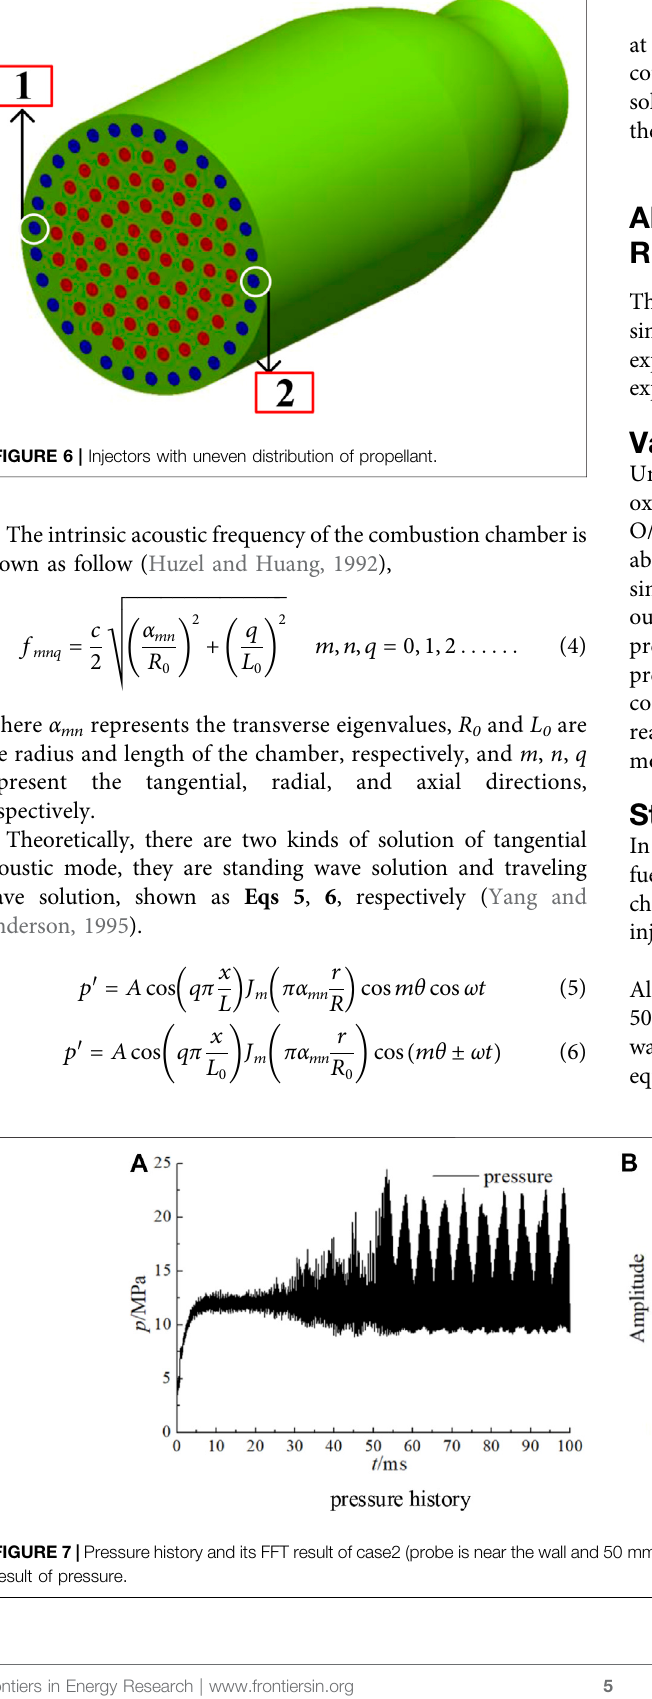
Frontiers in Energy Research |